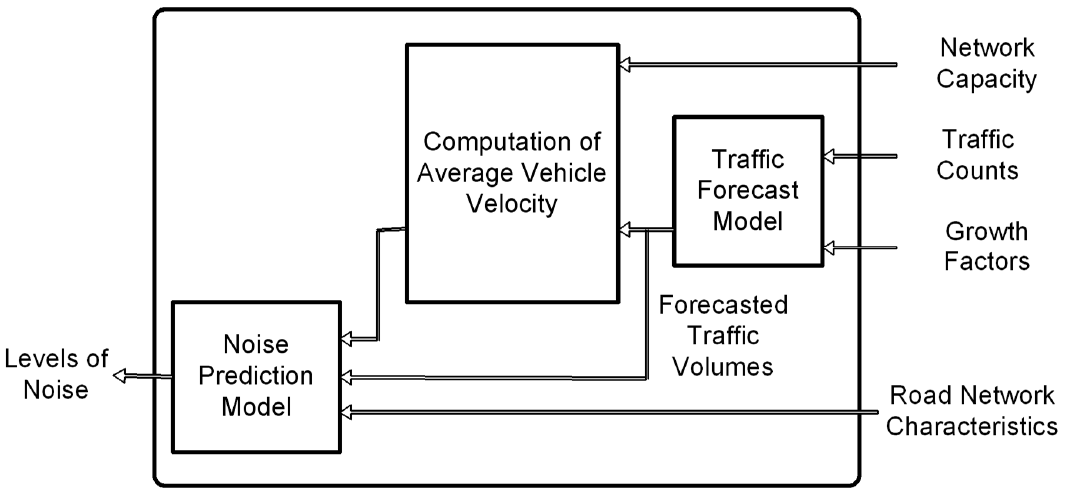
Figure 4. Computation of the levels of noise at certain links of a road network.